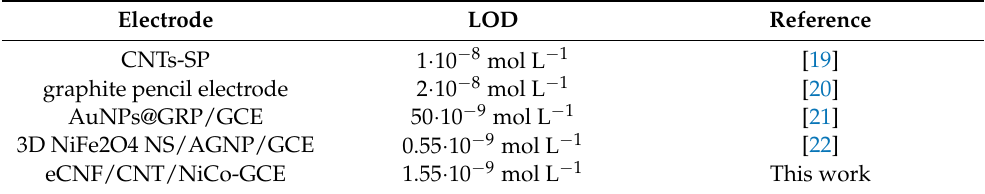
Table 1. Comparison of the vortioxetine detection limits obtained using other analytical